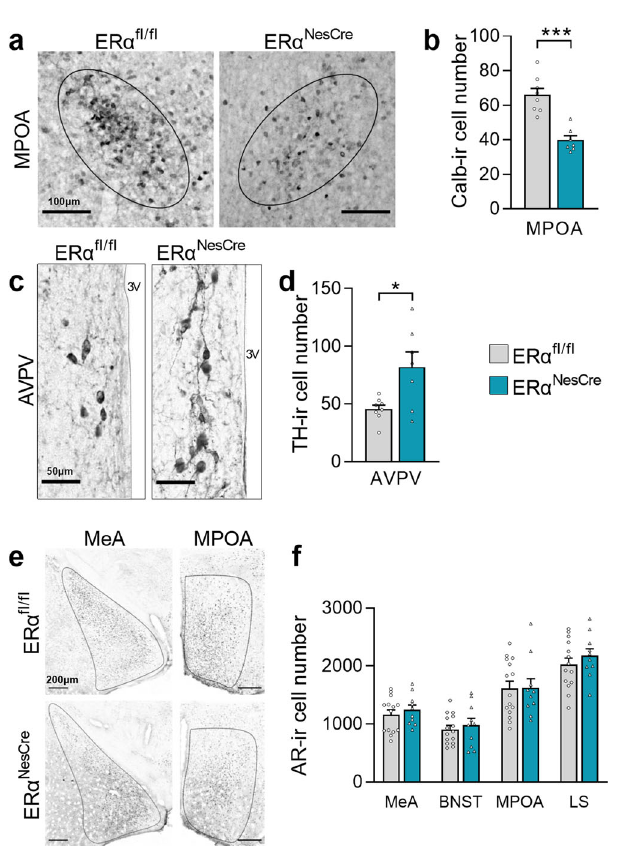
Fig. 4 Neural ER α deletion altered the organization of sexually dimorphic populations. a Representative calbindin-immunoreactivity (ir) in the medial preoptic area (MPOA) of control (ER α fl / fl ; left ) and mutant males (ER α NesCre ; right ). Scale bar 100 µ m. b Quanti fi cation of calbindin-ir neurons in control and mutant males ( n = 7 – 8 per genotype), *** p < 0.001 vs controls. c Representative images of tyrosine hydroxylase (TH)-ir in the in the anteroventral periventricular area (AVPV) of control (left) and mutant (right) males. Scale bar 50 µ m. d Quanti fi cation of TH-positive neurons in the AVPV, * p < 0.05 versus controls ( n = 7 – 8 per genotype). e Representative androgen receptor (AR)-ir in the medial amygdala (MeA; left) and the MPOA (right). Scale bars = 200 µ m. f Quanti fi cation of the number of AR-ir neurons in the MeA, bed nucleus of stria terminalis (BNST), MPOA, and lateral septum (LS) in controls and mutants ( n = 10 – 15 males per genotype); p = 0.3 and 0.9, respectively. All data are shown as means ± S.E.M. with individual values.